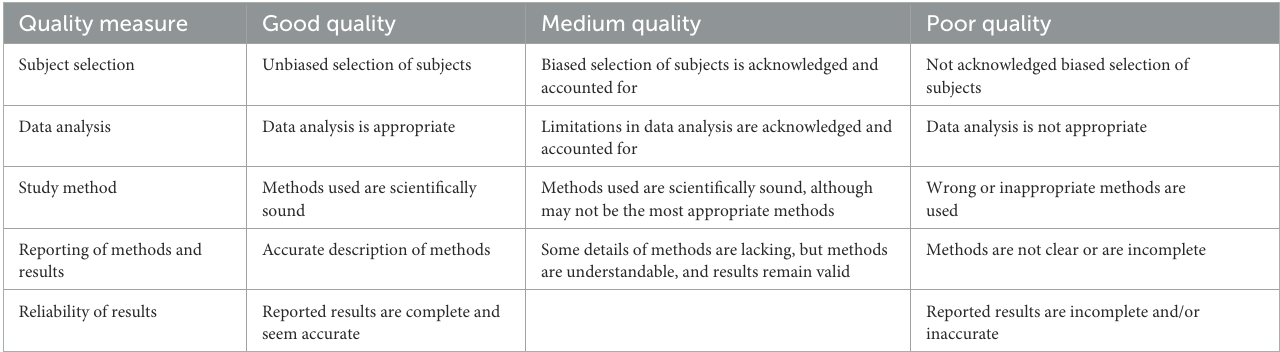
TABLE 2 Quality criteria used for the quality